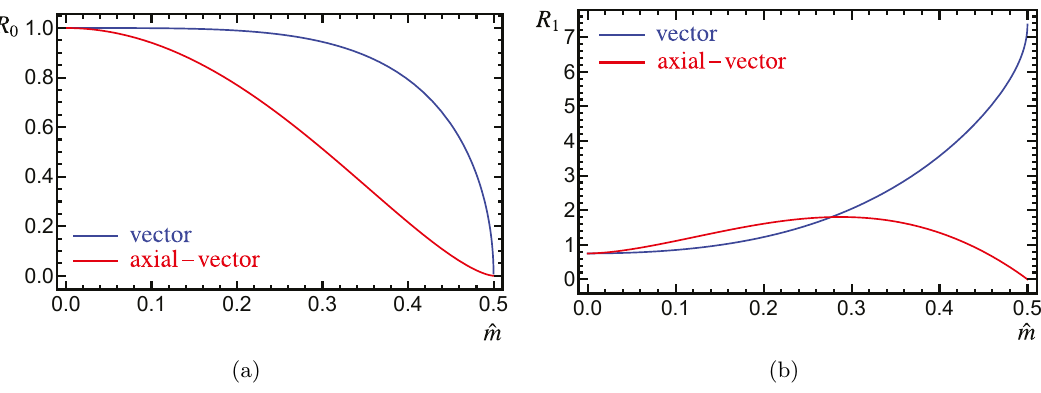
Figure 4 . Massive total hadronic cross section for vector (blue) and axial-vector (red) currents, at tree-level in panel (a) and one loop in panel